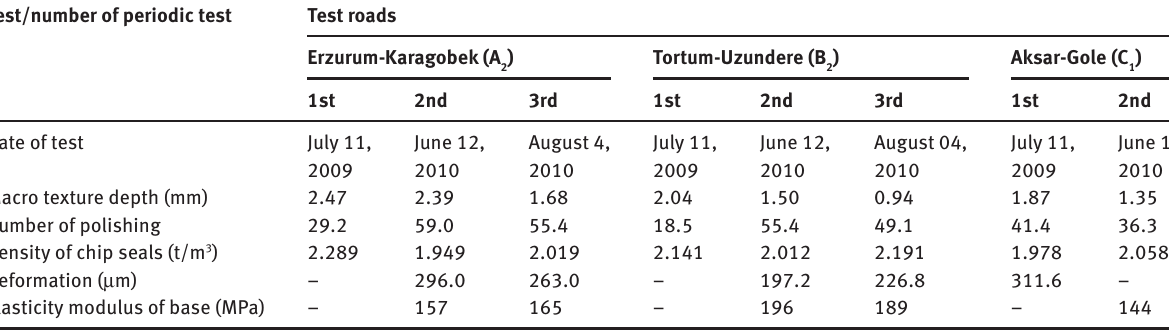
Table 8: Nondestructive test results of left wheel path’s (3) points. Test/number of periodic